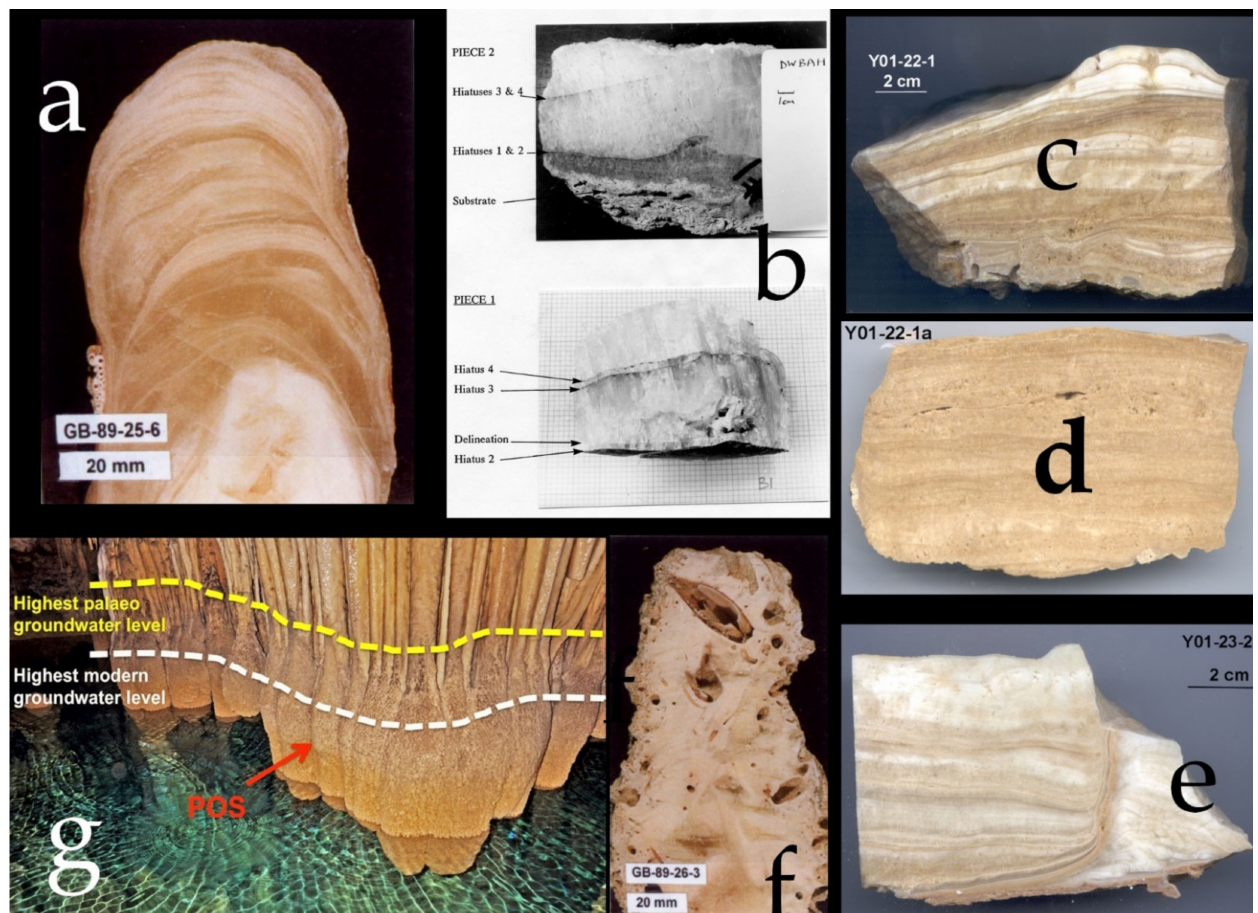
Figure 7. Submerged speleothems from the Caribbean. ( a ) Bahamas Blue hole, South Andros, Scheme 89. partially covered by serpulid overgrowths, − 13.8 m, Lucayan cavern (courtesy of David Richards). ( b ) The DWBAH flowstone, sampled at − 15 m in the Grand Bahama Island (courtesy of Joyce Lundberg). ( c , d ) Flowstone Y01-22-1, Y01-22-1a, − 9.9, Yucat á n (courtesy of Gina Moseley). ( e ) Flowstone Y01-23-2, − 4.9, Yucat á n (courtesy of Gina Moseley). ( f ) Bahamas Blue hole, South Andros., stalagmite GB-89-26-3 a stalagmite bored by Lithophaga (courtesy of David Richards). ( g ) Japan, phreatic speleothem at Minaido Daito island (courtesy of Blaz